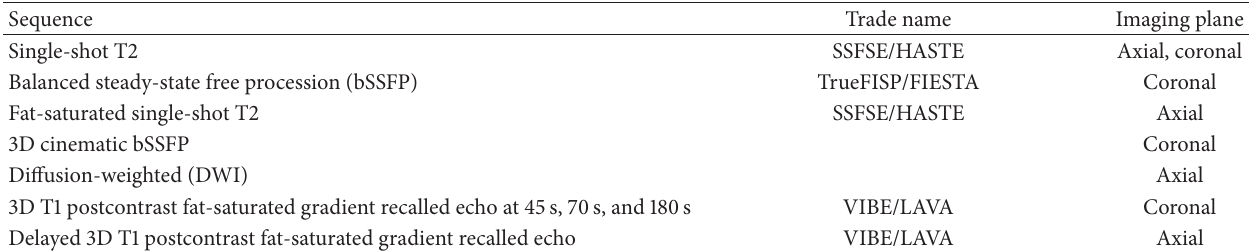
Table 1: MR enterography pulse